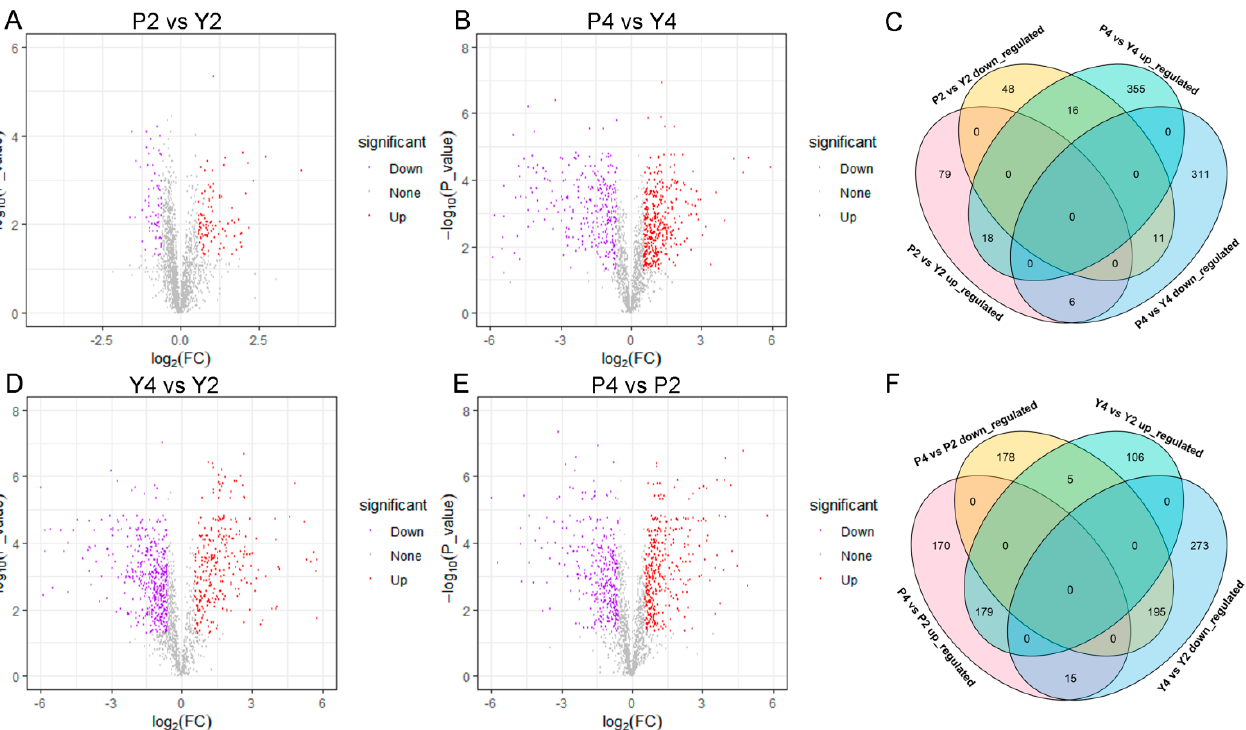
Figure 4. Analysis of the DEPs in four comparison groups, respectively. ( A , B , D , E ) Volcano plots of the DEPs in four comparison groups; ( C ) Venn diagrams of upregulated and downregulated DEPs between P2 vs. Y2 and P4 vs. Y4; ( F ) Venn diagrams of upregulated and downregulated DEPs between Y4 vs. Y2 and P4 vs. P2.